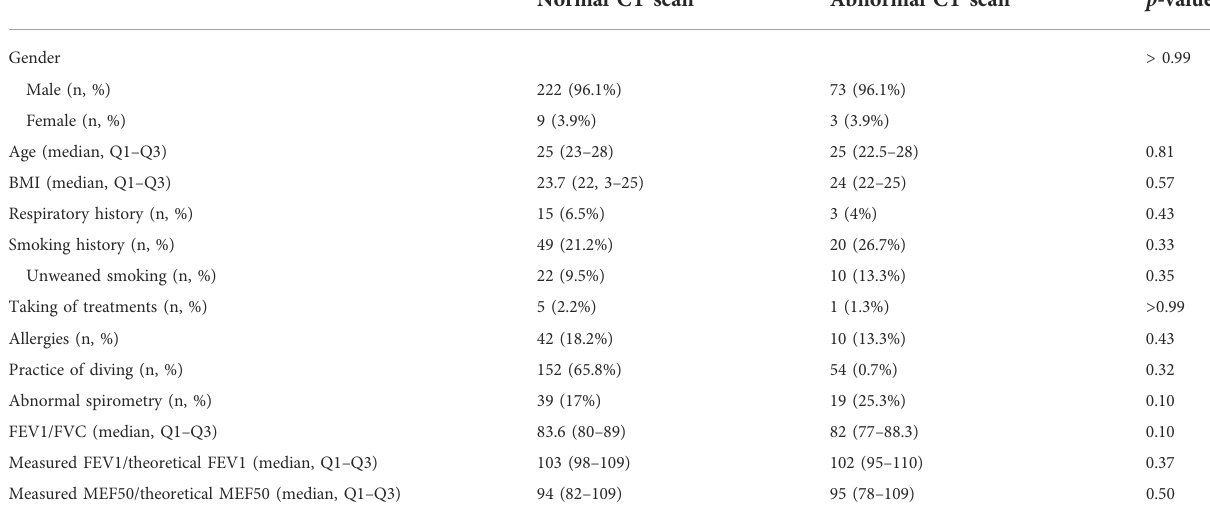
TABLE 3 Characteristics of subjects according to a normal or abnormal CT scan result.